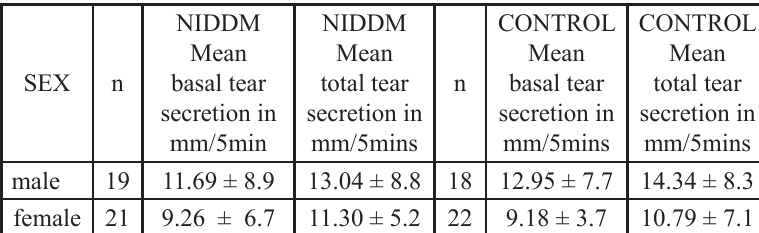
Table 1: Mean basal tear secretion and mean reflex tear secre - tion for males and females in both NIDDM and controls groups